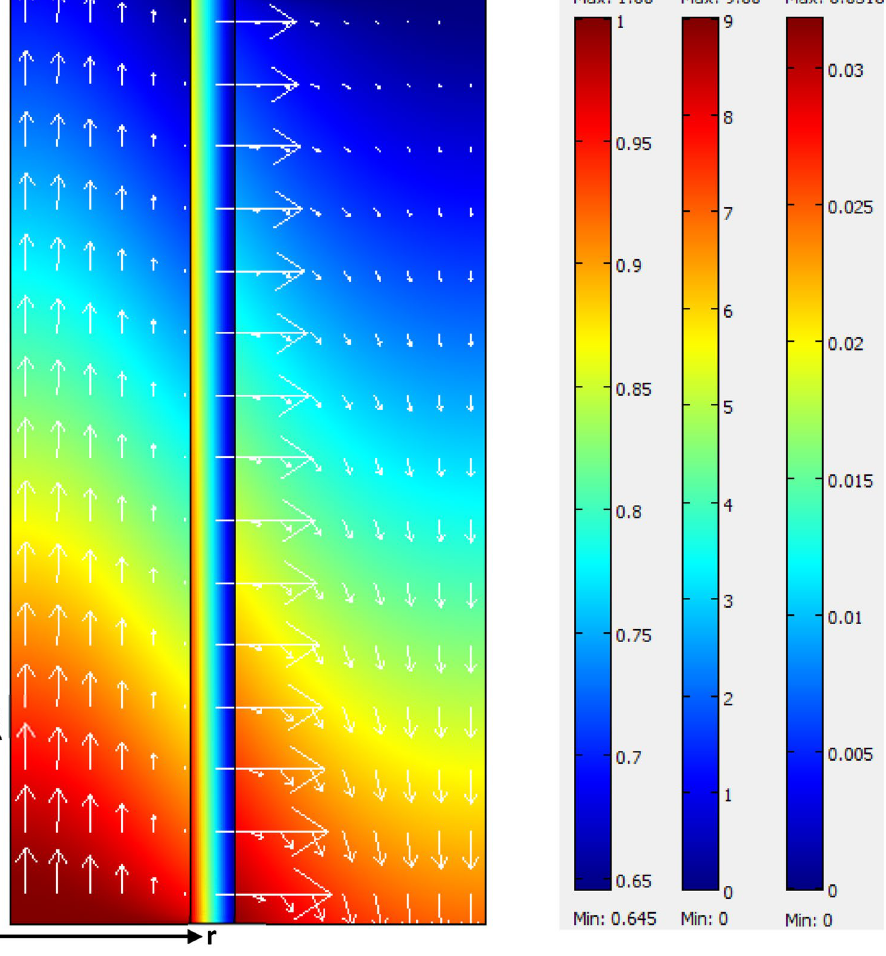
Figure 4. Uranium concentration distribution and its total